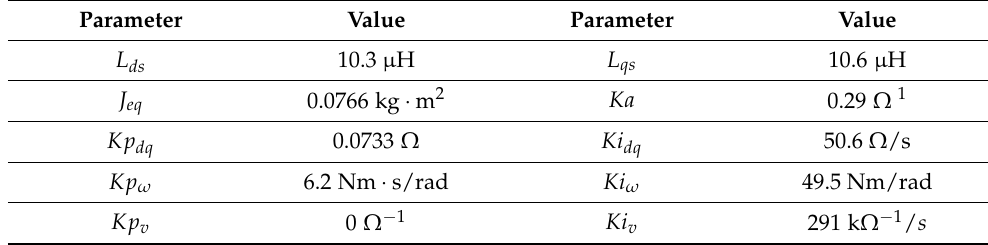
Table 4. Controllers Design in SI base units.